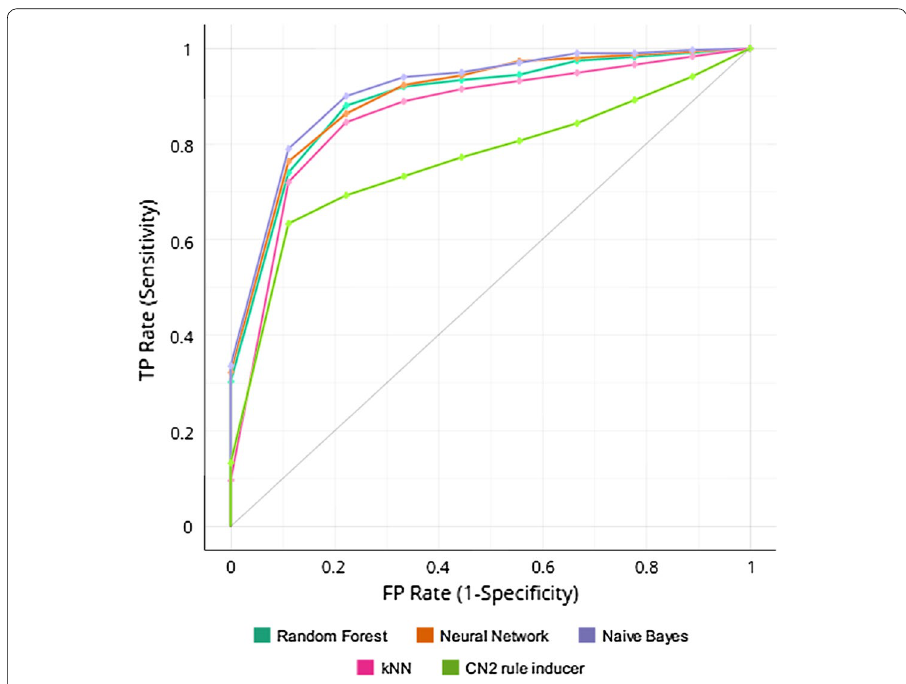
Fig. 13 ROC for the LDT IP download TSC